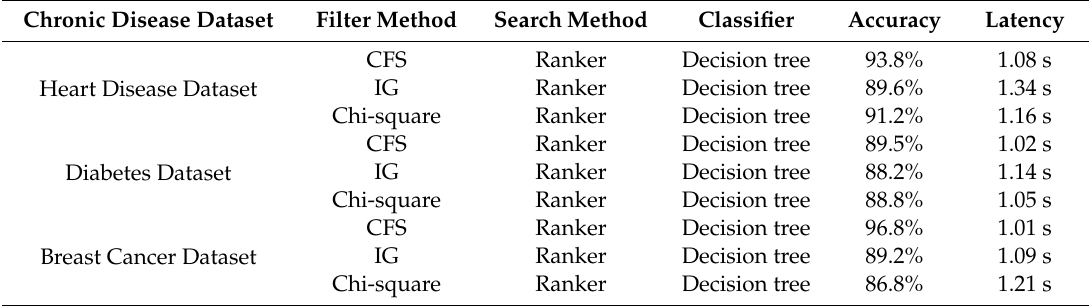
Table 9. Analysis of classification accuracy and latency with filter methods on disease